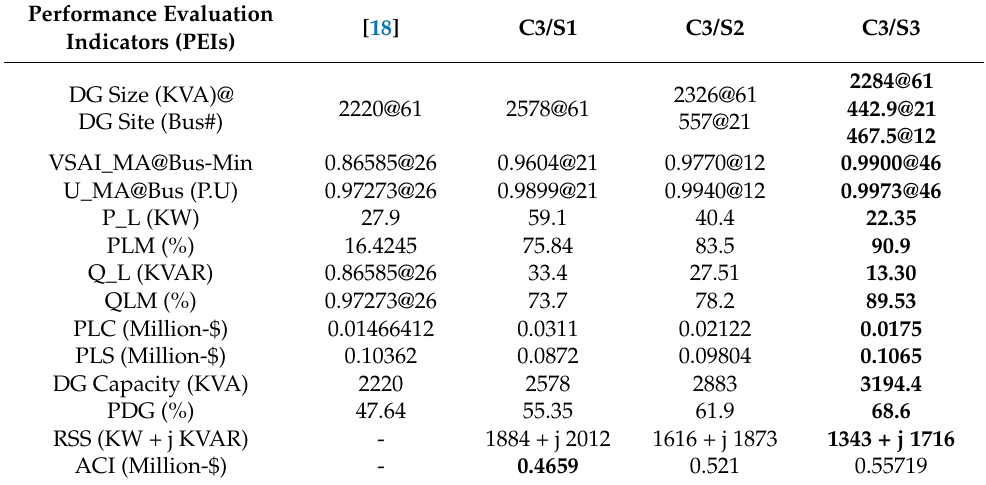
Table 9. Comparisons of results with various scenarios of Case 3 for 69-Bus test system (DG @ pf = 0.90 ±